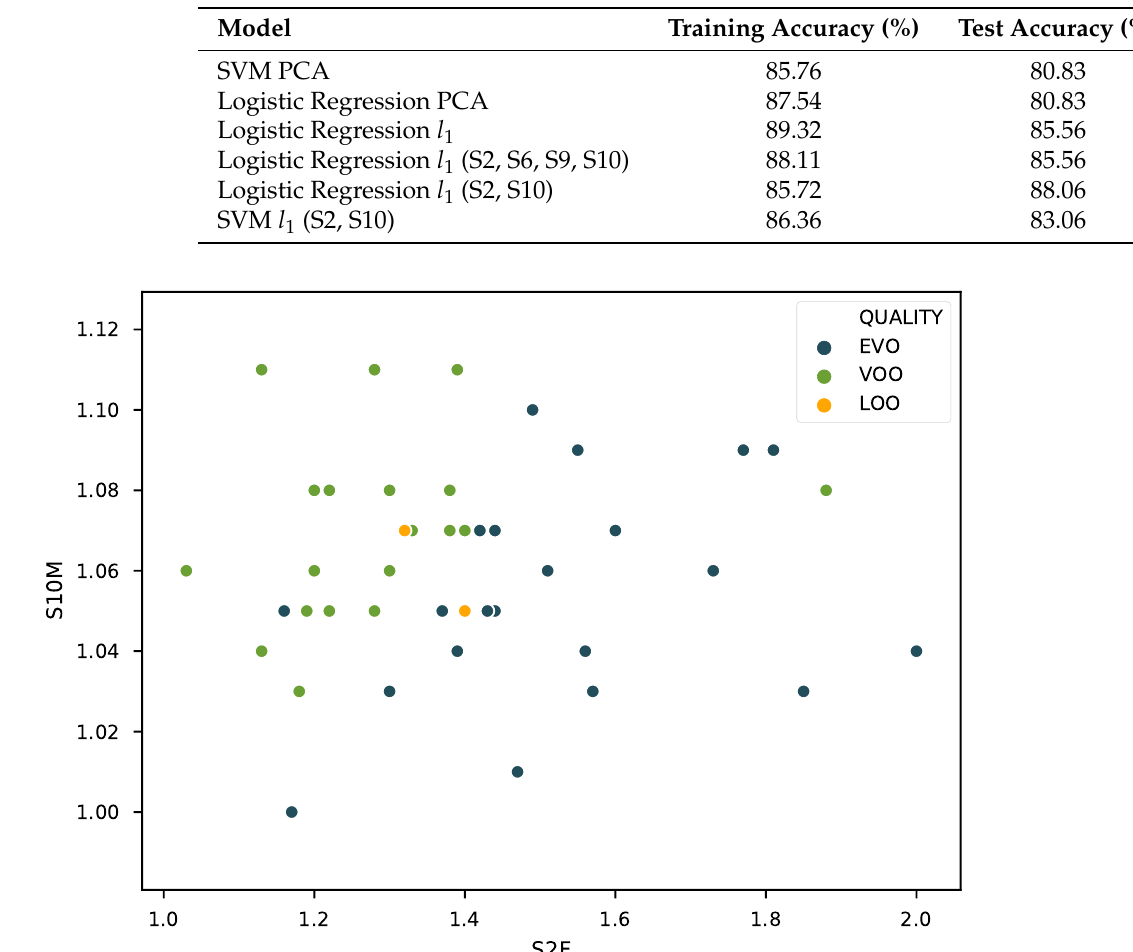
Figure 10. Visualization of the feature space yielded by S2F and S10M. The classes are almost completely linearly